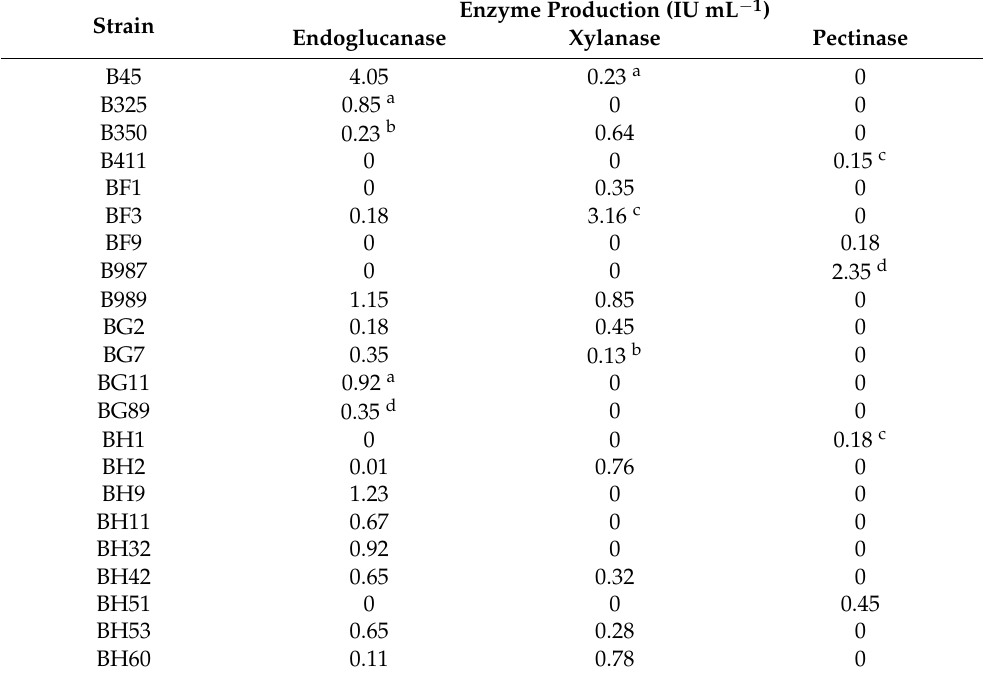
Table 2. Endoglucanase, xylanase and pectinase production by the selected isolates. The isolates were separately cultivated in Mineral Salt medium containing carboxymethylcellulose, xylan and pectin and the enzyme activities were detected in cell-free culture supernatant.